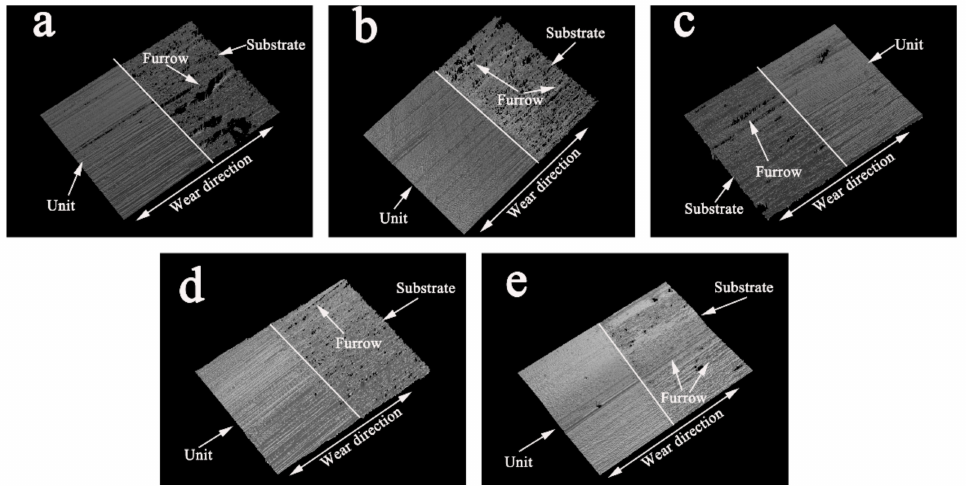
Figure 16. Wear morphology of the bionic samples: ( a ) LR-A1, ( b ) LR-A2, ( c ) LR-A3, ( d ) LR-A4, and ( e )